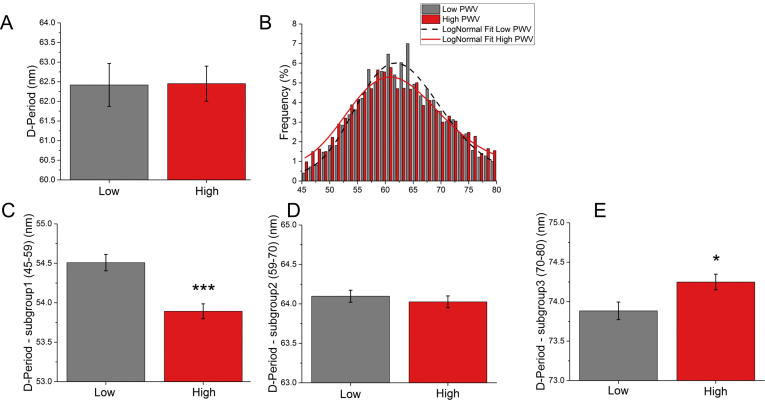
Collagen fibril D-Period in the low and high PWV groups . (A) Bar graph showing mean ± SEM (n = 7 and n = 9 patients in the low and high group) (Mann-Whitney U test, pvalue = 0.8) (B) Distribution of diameters in the two groups (n = 3201 and 3994 measurements in the low and high PWV groups respectively). The distributions were statistically different (Kolmogorov-Smirnov, p-value < 0.0001). (C)–(E) D-Period values shown in 3 sub-groups. There was a statistically significant difference in the low sub-group, 45–59 nm (Mann- Whitney U test, adj p-value < 0.0001) and also in the high sub-group, 70–80 nm (Mann- Whitney U test, adj p-value = 0.046).